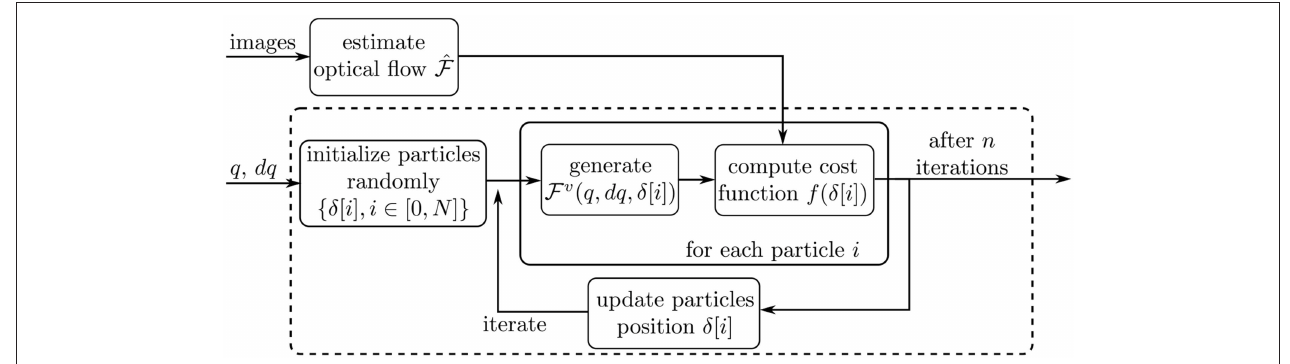
FIGURE 6 | Schematic describing the optimization workflow. The dashed box outlines the Particle Swarm Optimization